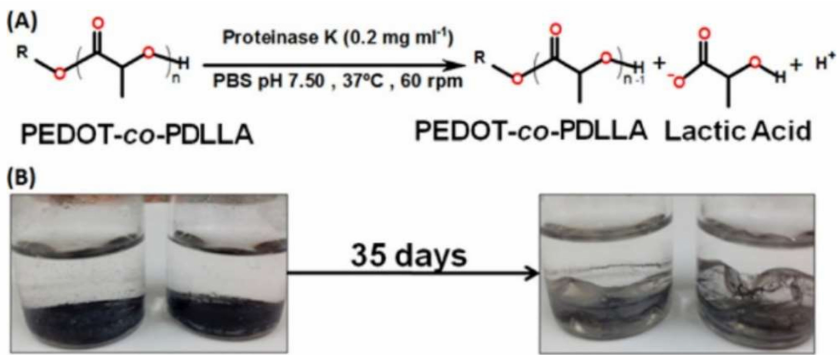
Figure 7. ( A ) Biodegradation Reaction and ( B ) Physical Aspects of PEDOT-co-PDLLA Films before and after 35 Days of Biodegradation Assay. Obtained from reference [139]. Copyright @ 2018, The Authors,